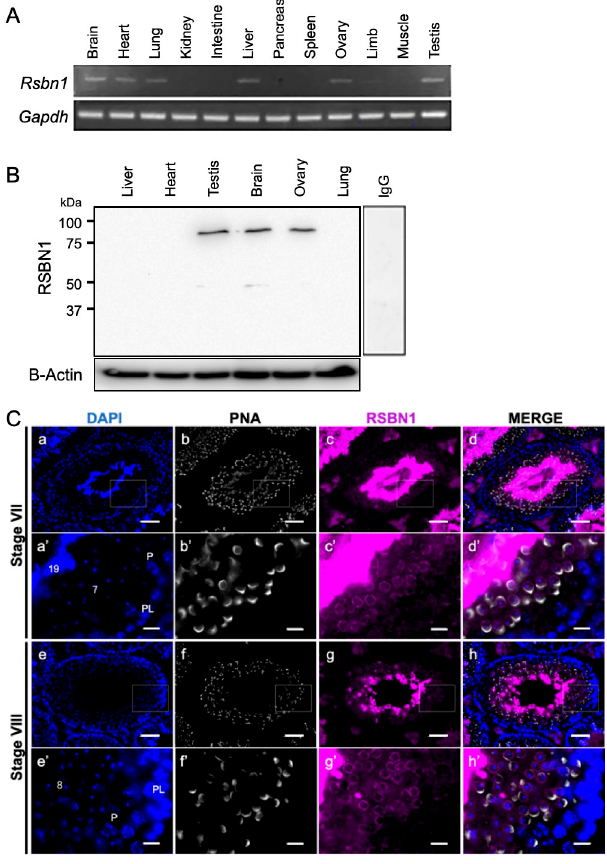
Fig 2. Expression and localization of RSBN1 in the testis. (A) Expression of Rsbn1 mRNA in multiple tissues. Transcripts of Rsbn1 were examined by semiquantitative RT-PCR in different tissue samples, GAPDH was used as an internal control. (B) Expression of RSBN1 protein in multiple tissues. A western blot results of RSBN1 protein in six different tissues are shown. Beta-actin was used as a loading control. (C) Localization of RSBN1 in the seminiferous tubules. Low magnification images (a-h) and high magnification images (a’-h’) of the localization of nucleus (DAPI, blue: a, a’, e, and e’), acrosome (PNA, white: b, b’, f, and f’), RSBN1 (magenta: c, c’, g, and g’), and merged images (d, d’, h, and h’) in the seminiferous tubule are shown. Scale bars = 50 μ m (a-h) and 10 μ m (a’-h’).